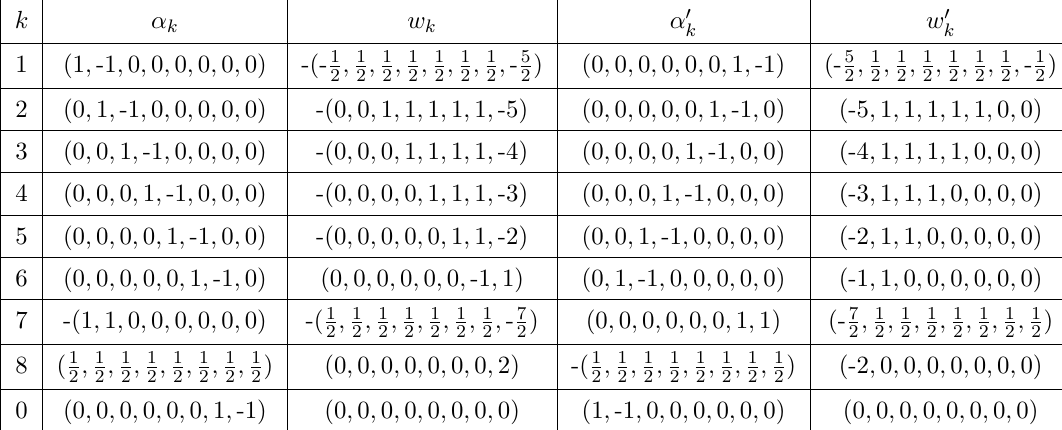
Table 5. Simple roots and fundamental weights of E 8 and E 0